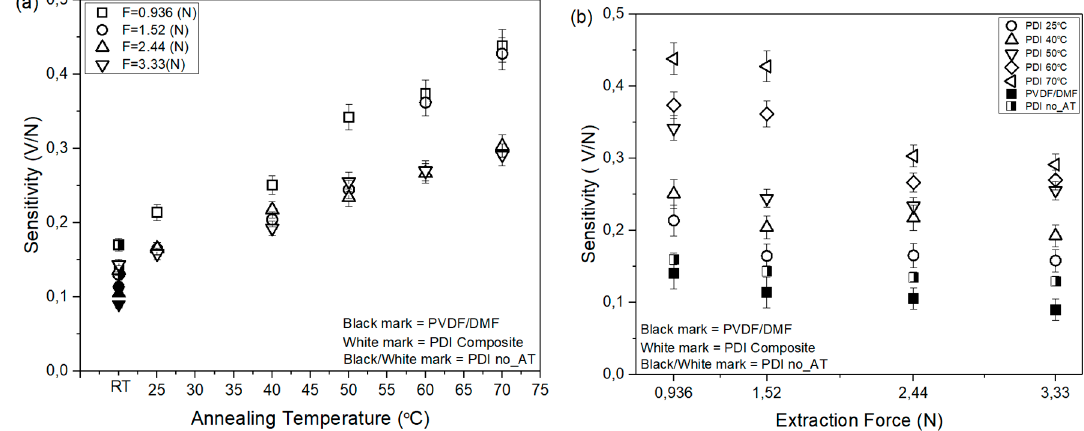
Figure 9. ( a ) Sensitivity ( d 31 ) vs. annealing temperature; ( b ) sensitivity vs. extraction force.